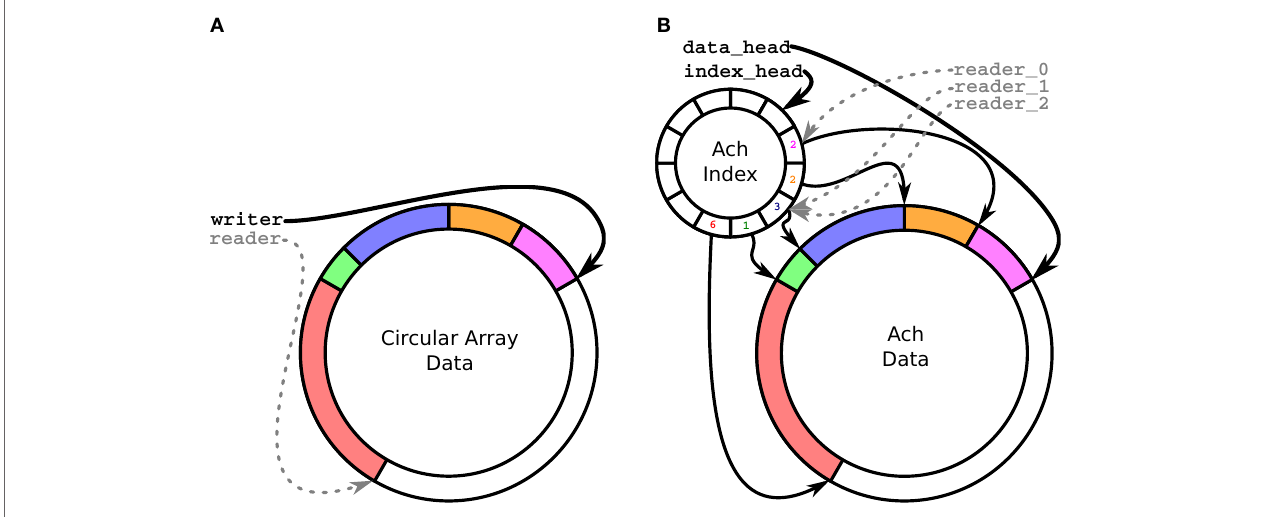
FigUre 1 | logical memory structure for a conventional circular buffer (a) and an ach channel (B) . (a) shows a single writer, single reader circular buffer. (B) shows the Ach data structure with separate index and data buffers. The index buffer records metadata on the messages, enabling multiple readers, and detection of overwritten